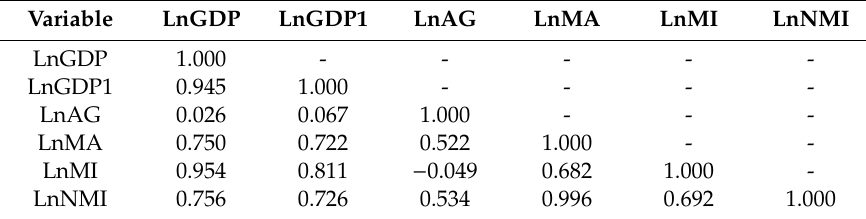
Table 3. Correlation between variables (in natural logarithms).